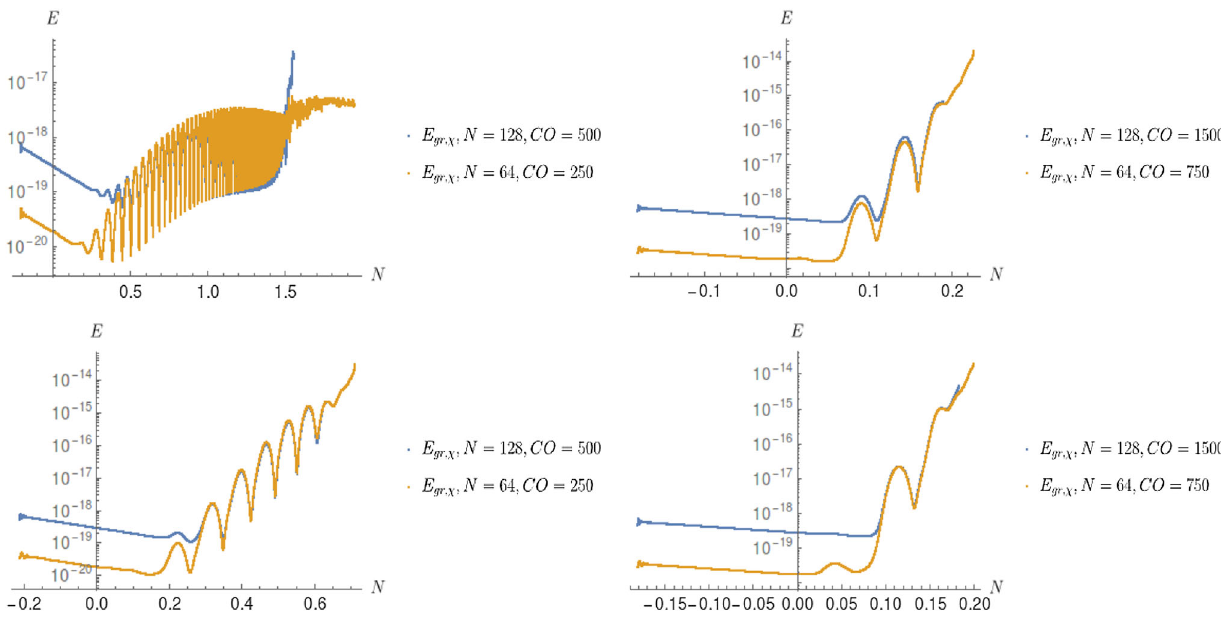
Fig. 16 The evolution of gradient energy density of the spectator perturbations for n = 1 ,α = 10 − 3 (upper left), n = 1 ,α = 10 − 4 (upper right), n = 1 . 5 ,α = 10 − 3 (lower left), n = 1 . 5 ,α = 10 − 4 (lower right) with the number of e-folds N after the end of inflation. Details of the simulations are described in the